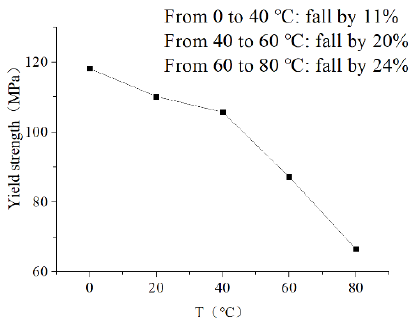
Figure 7. Yield strength of XLPE specimens at different temperatures.